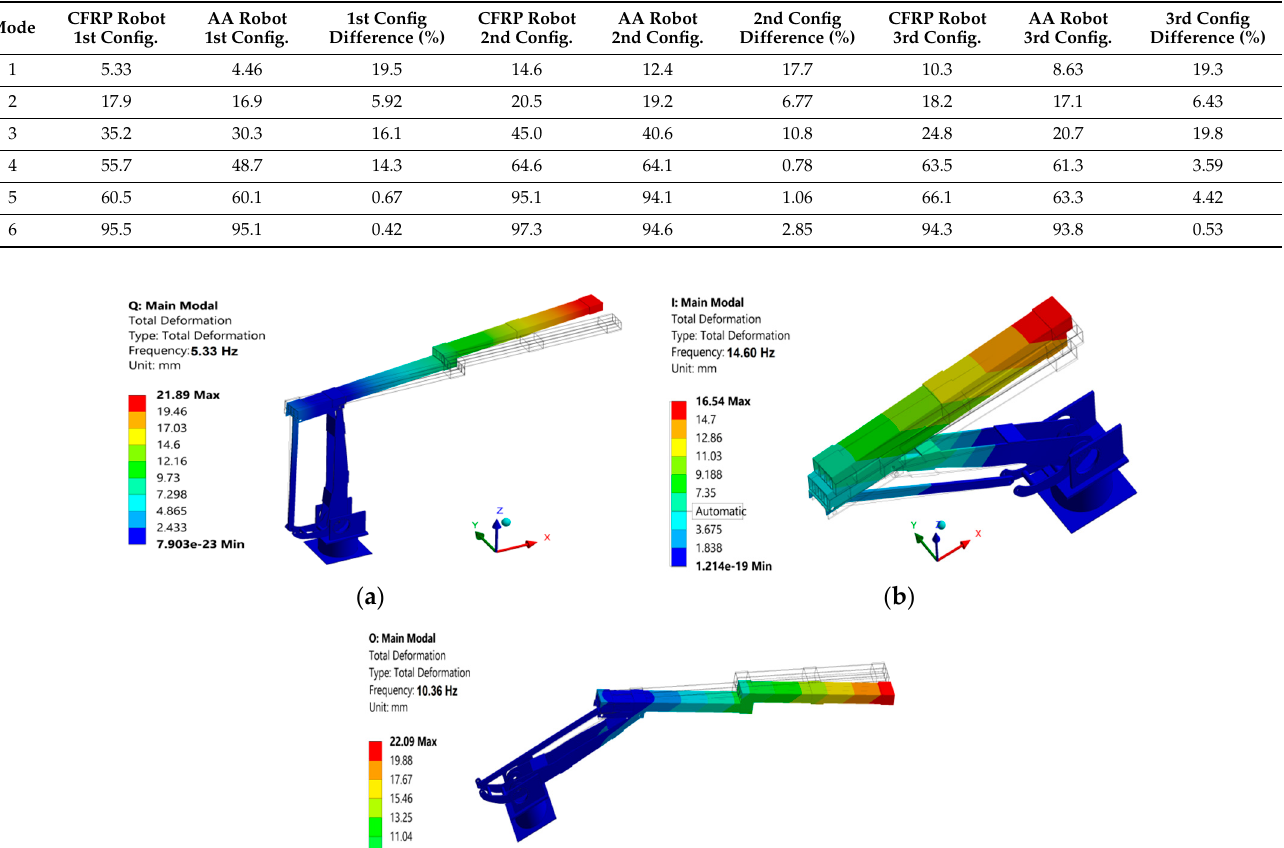
Table 8. Natural frequencies of the AA and CFRP manipulators under three configurations (Hz).